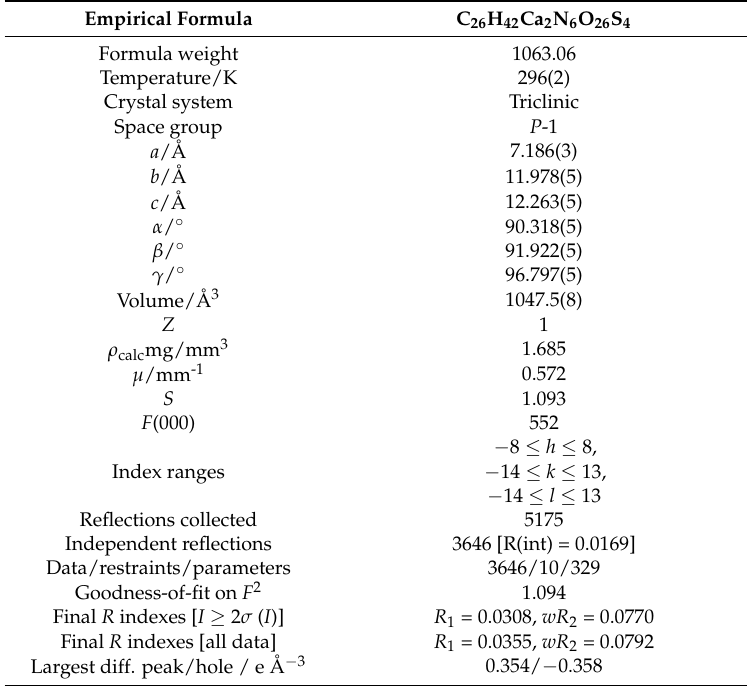
Table 4. Crystal data for complex